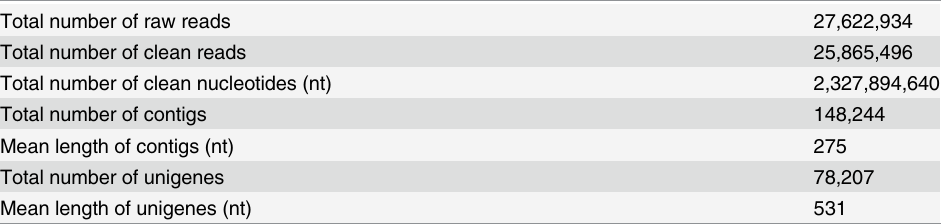
Table 1. Summary of the de novo transcriptome assembly of P . quinquefolius